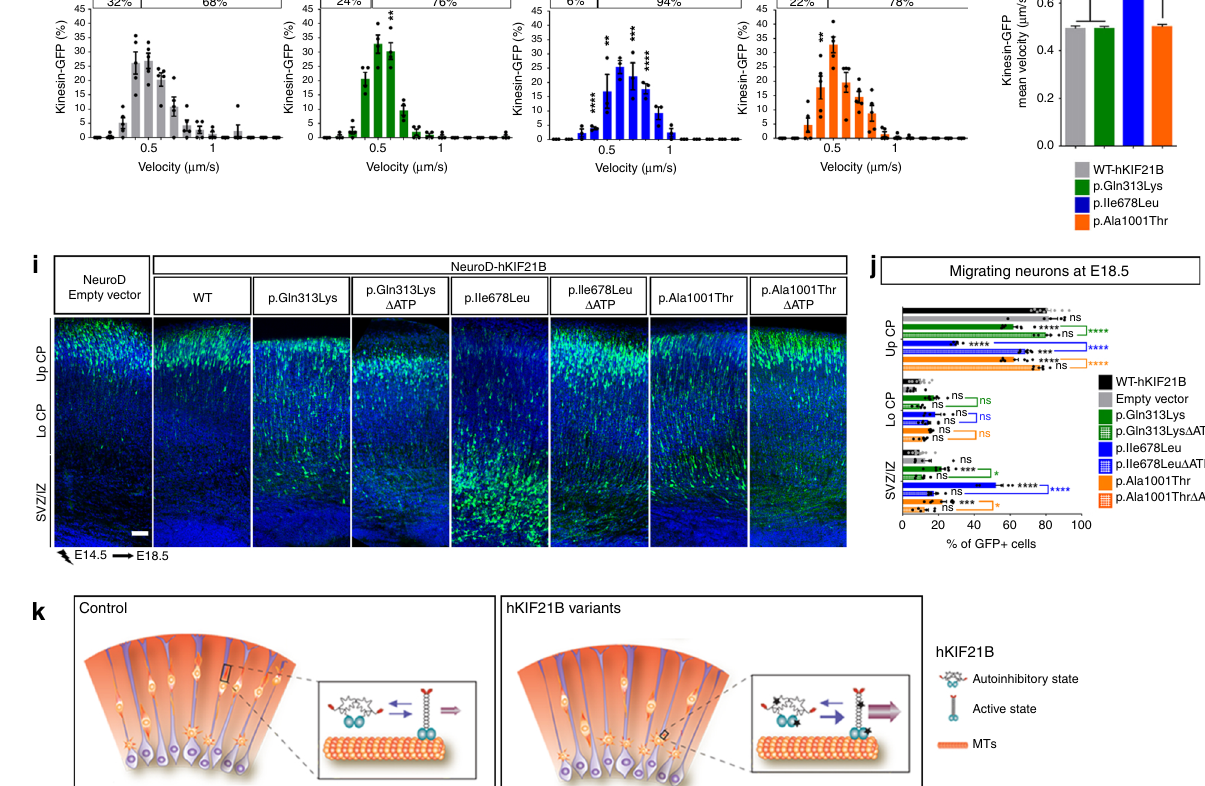
mainly at the periphery of the cells, suggesting an enhanced motility toward the plus end of the microtubules (Fig. 4e). To note, WT and all mutant proteins showed similar distribution in soma and neurites when overexpressed in primary cortical neurons (Supplementary Fig. 4c). Interestingly, in 100% of